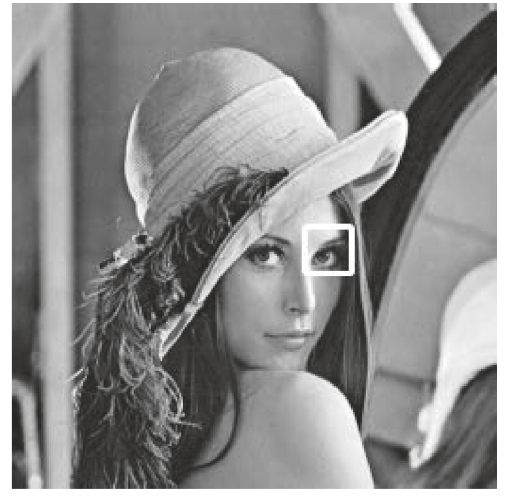
Figure 4: Template matching original image. Table 2: Results of template